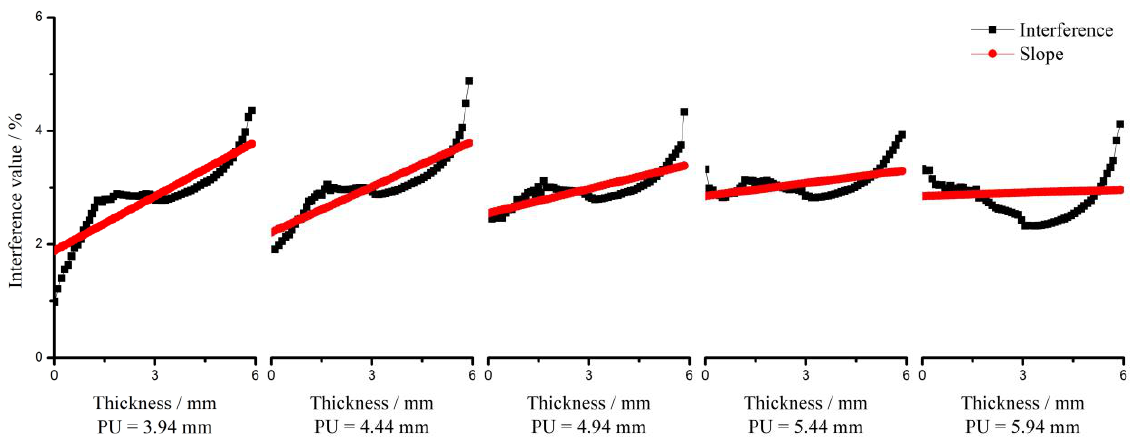
Figure 11. The homogeneousness of different interference distribution conditions.